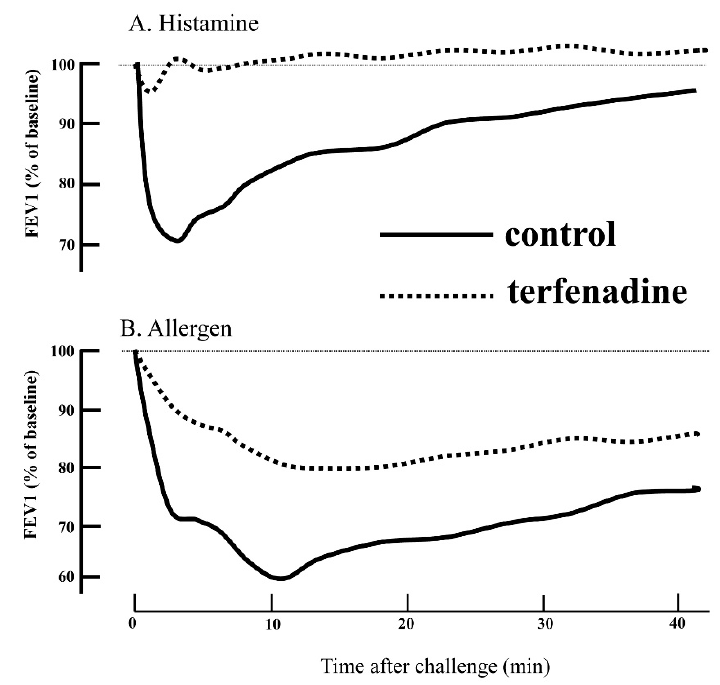
al., The contribution of histamine to immediate bronchoconstriction provoked by inhaled allergen